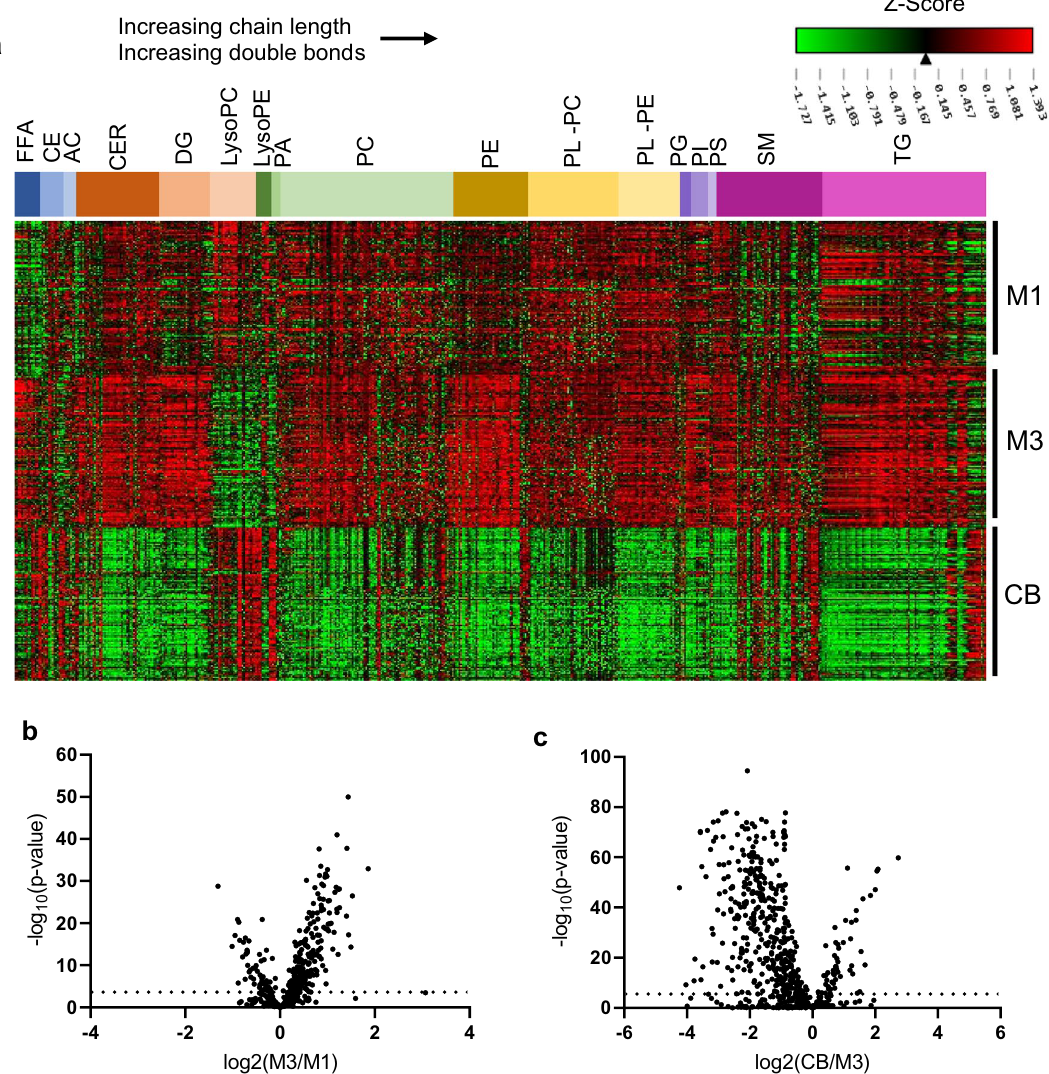
Figure 2. Dynamic changes in maternal and cord blood plasma lipidome during pregnancy. ( a ) Heatmap of standardized peak intensity for individual lipids (mean 0, standard deviation 1). Lipids are grouped by lipid class with increasing total chain length and double bond from left to right in each lipid class. ( b ) Differences between M1 and M3 lipidome using log2FC. Lipids that are greater in M1 than M3 have a positive log2FC. Of the 573 lipid species analyzed, 35% were significantly increased and 10% were decreased (Bonferroni adjusted, α = 0.05/573). ( c ) Differences between M3 and CB lipidome using log2FC. Of the 573 lipid species analyzed, 10% were significantly increased and 61% were decreased (Bonferroni adjusted, α = 0.05/573). Lipids that are greater in M3 than CB have a positive